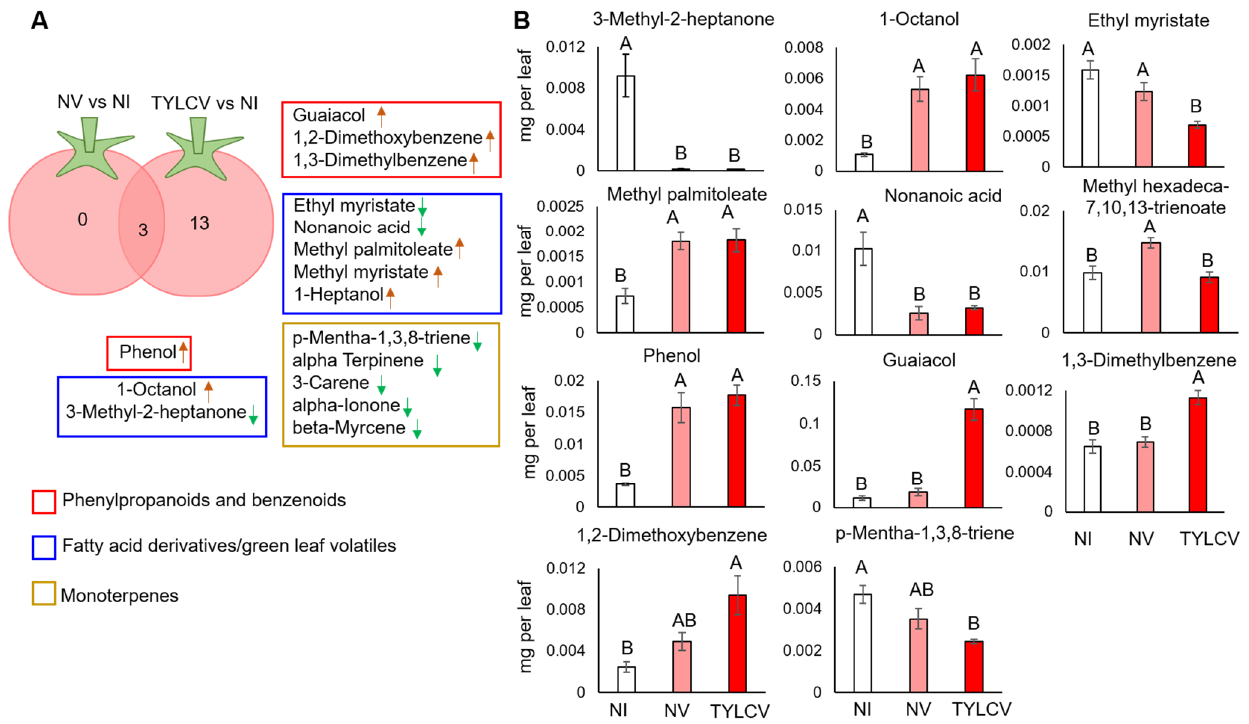
Figure 2. Altered VOC profiles of tomato plants. ( A ) Venn diagram representing the altered VOC profiles of tomato plants inoculated with viruliferous (TYLCV) and non-viruliferous whiteflies (NV) compared to non-inoculated control plants (NI) using Student’s t -test ( p < 0.05, FDR corrected). Red, blue, and golden rectangles denote phenylpropanoid and benzenoid, fatty acid derivatives, and terpenes classes of volatiles, respectively. The arrows represent the direction of change: increase (brown) and decrease (green). ( B ) Mean quantities of volatiles detected from tomato leaves of plants (N = 5) of non-inoculated control (NI), inoculated with viruliferous whiteflies (TYLCV), or non- viruliferous whiteflies (NV). Mean quantities were compared by one-way ANOVA Tukey’s HSD test, and significant differences ( p < 0.05) are indicated by different